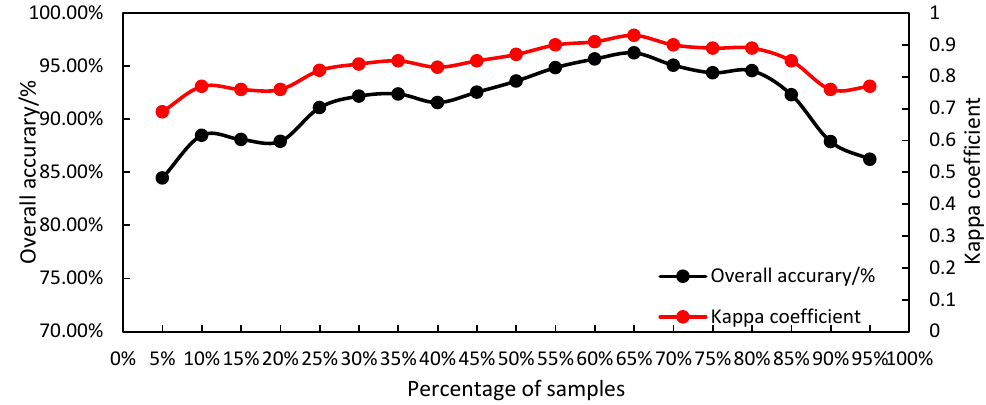
Figure 6. Overall accuracy and kappa coefficient of the random forest (RF) model based on samples with different purities.